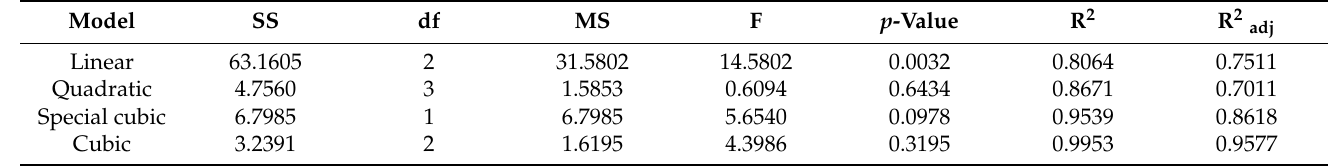
Table 3. ANOVA results for different statistical models for E. coli PCM 2057.